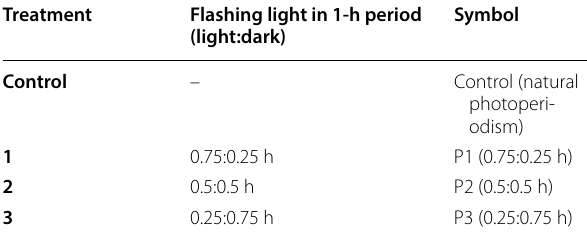
Table 3 Treatment in 35-L airlift photobioreactors Treatment Flashing light in 1-h period